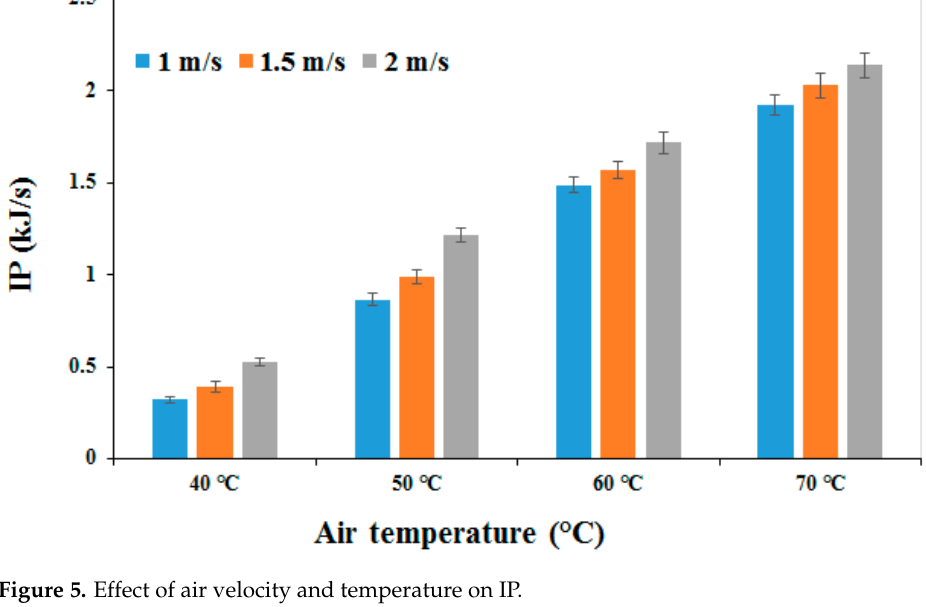
Figure 5. Effect of air velocity and temperature on IP.